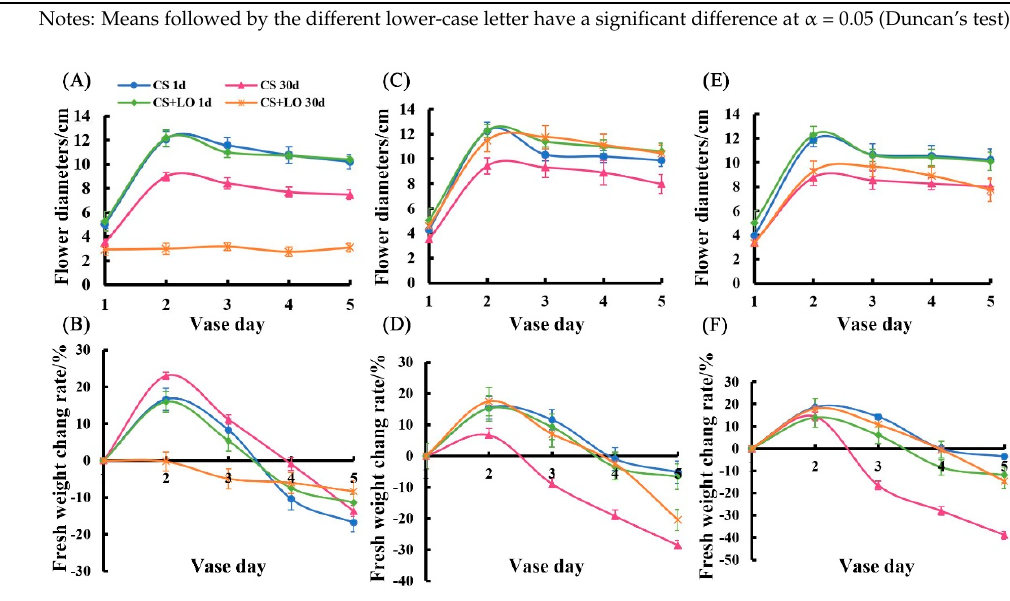
Table 3. Flowering rate and vase life of cut flowers under 8-HQ and NS pre-treatment and CS and CS + LO storage .